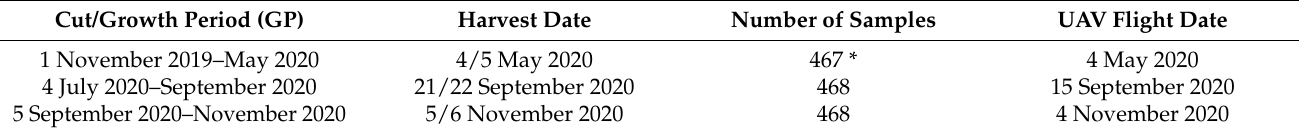
Table 2. Biomass sampling information (* information on one sample